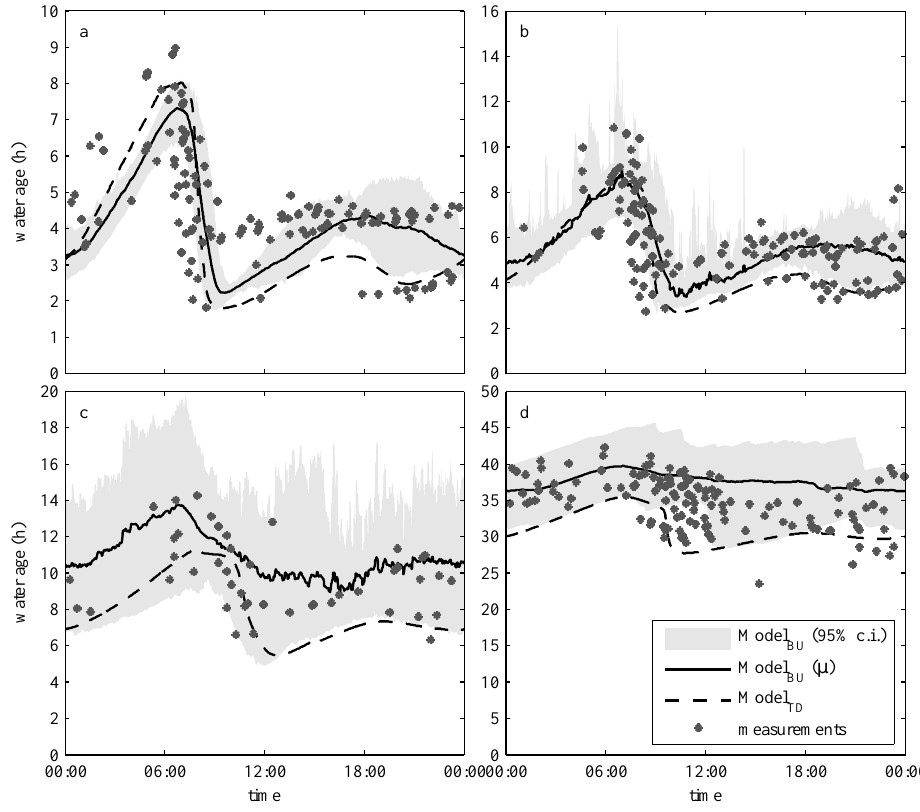
Figure 7. Measured and modelled water age at location (a) 1; (b) 2; (c) 3 and (d) 4. N.B. the 95% confidence interval is due to variation, not to uncertainty. Table 4. Average absolute and relative di ff erences between measured and modelled water